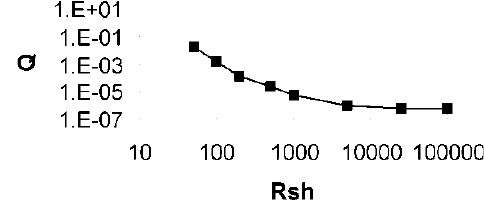
FIGURE 3 Q function versus R sh for an ideal characteristic ( A ¼ 1.4; R s ¼ 2.5 O ; I 0 ¼ 5 (cid:3) 10 (cid:1)